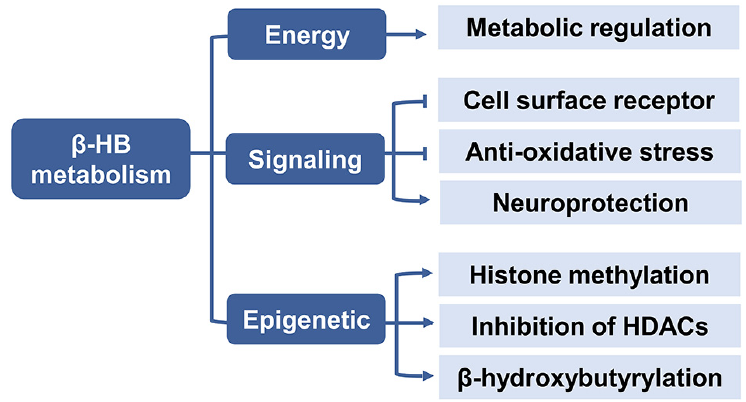
Figure 3. The metabolic role of β -HB. β -HB acts as an energy substrate to regulate metabolic response, and serves as a signaling molecule to inhibit lipolysis, oxidative stress and improve neuroprotection, it also plays a role in epigenetic regulation including histone methylation, inhibition of HDACs, and histone lysine β -hydroxybutyrylation. Abbreviations: β -HB, β -hydroxybutyrate; HDAC, histone deacetylases.